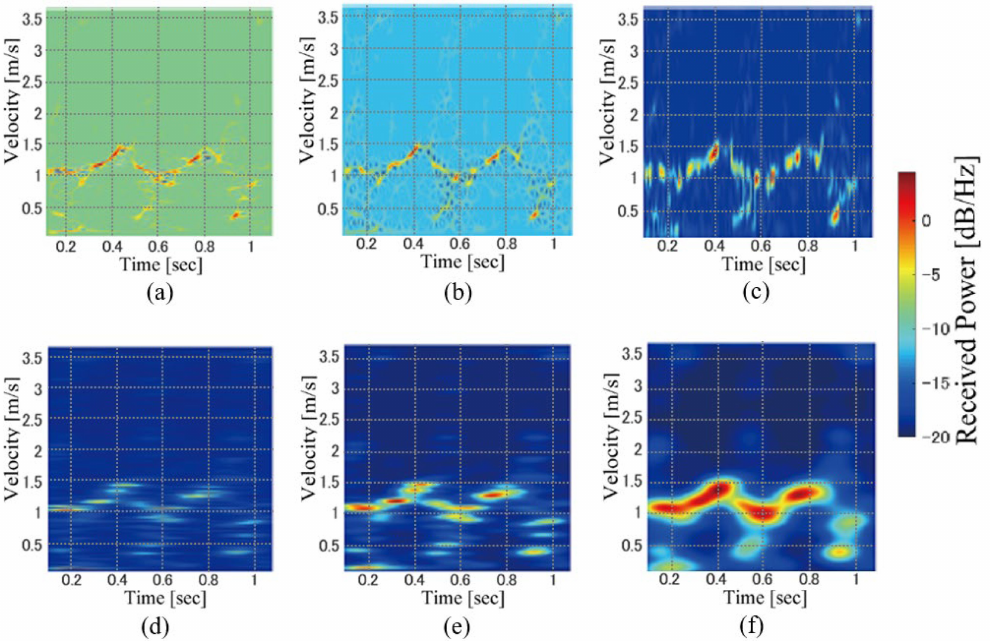
Figure 6. Examples of SPWVD images. ( α , β ) = ( a ) (4, 4) , ( b ) (4, 16), ( c ) (4, 64), ( d ) (64, 4), ( e ) (64, 16), and ( f ) (64,